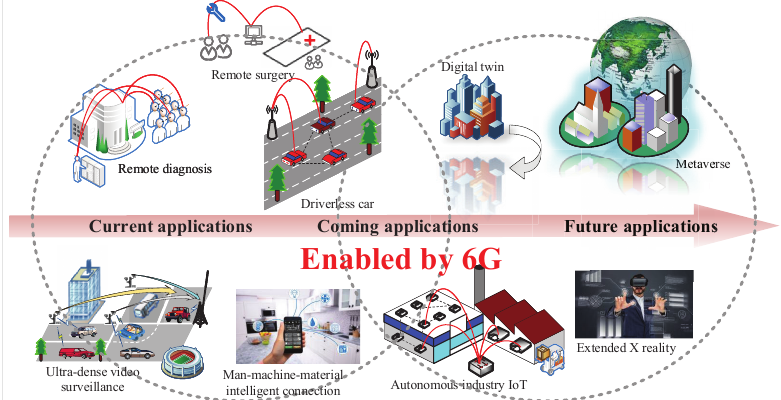
Figure 2. Coming and future applications enabled by